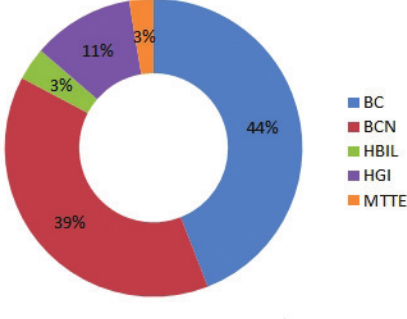
Figure 2. Origin herbarium of the specimens included in the